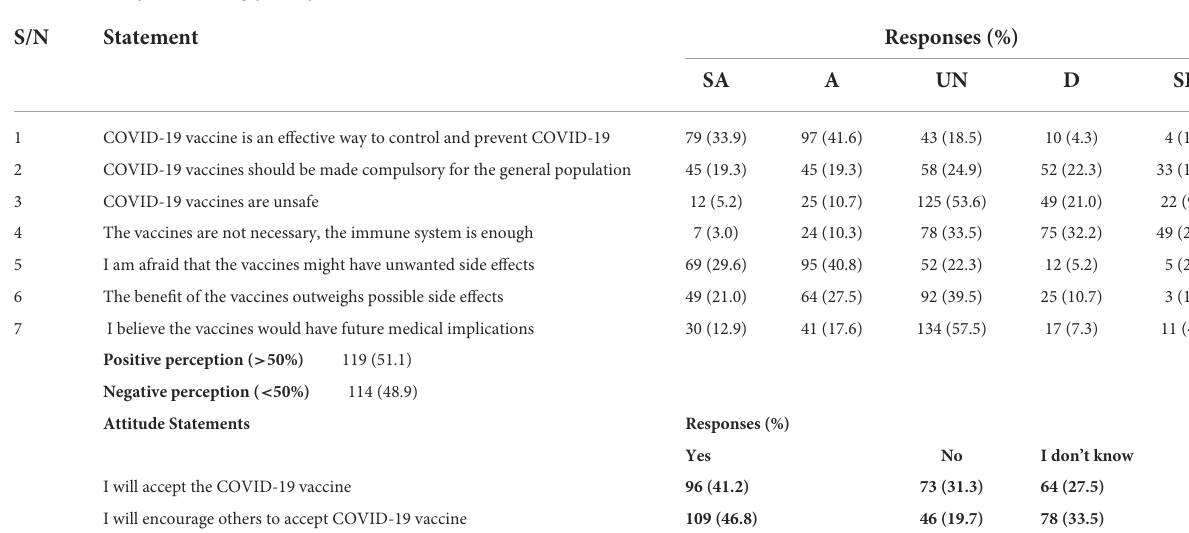
TABLE 3 Perception of study participants on COVID-19